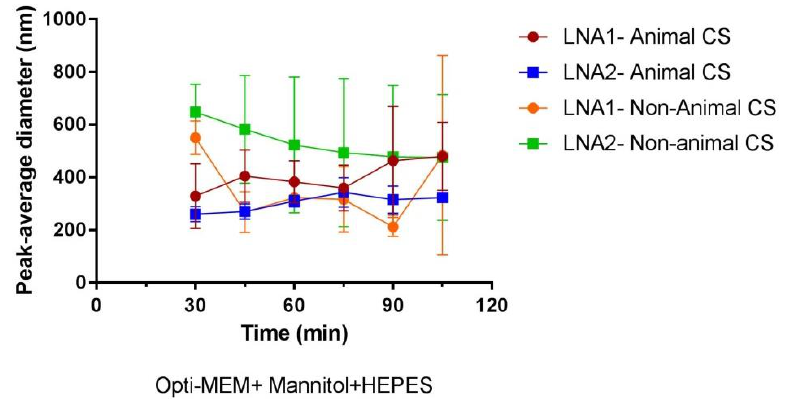
Figure 8. Stability of the LNA-CS NPs after initial incubation for 30 min and after every 15 min over the course of 105 min in Opti-MEM containing HEPES (4-(2-hydroxyethyl)-1-piperazineethanesulfonic acid) and mannitol at 37 °C. The values represented are the mean ± SD of three independent experiments.